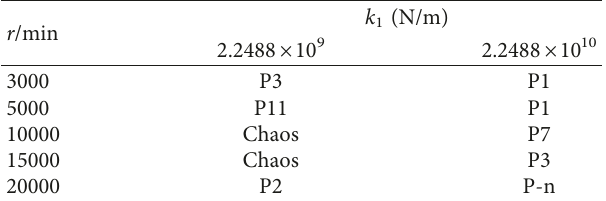
Figure 11: System response for ω � 20000r/min. (a) Phase portraits. (b) Poincar´e map. Table 1: Motion characteristics of the motorized